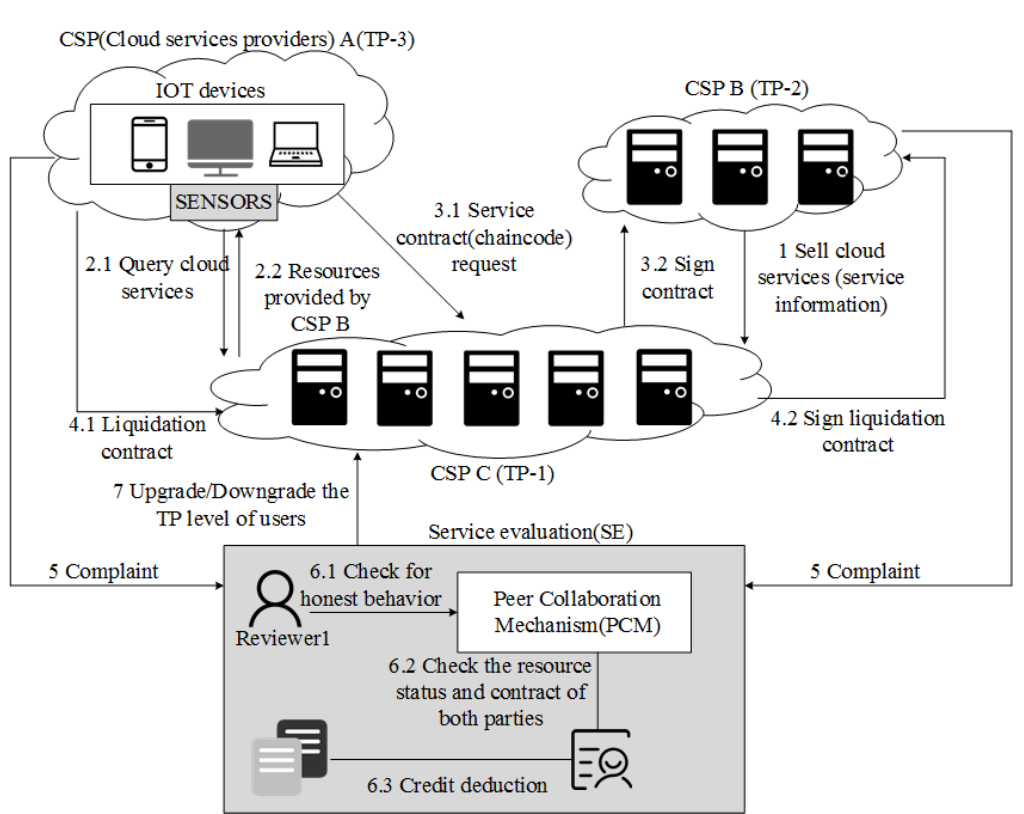
Figure 2. Reconstruction diagram of reference [23].